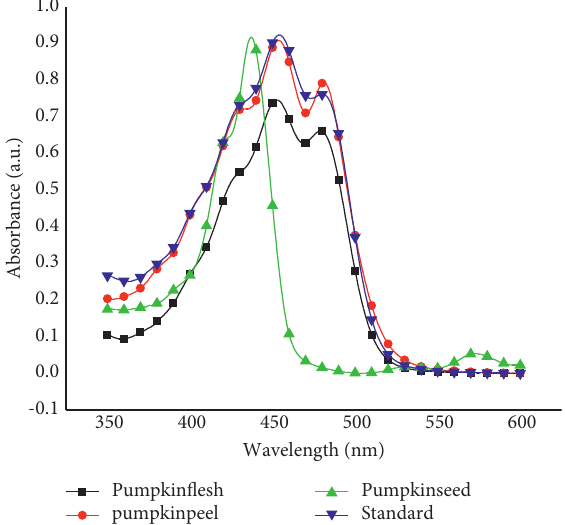
Figure 4: UV-VIS spectra of standard β -carotene and β -carotene extracts from pumpkin flesh, peel, and seed samples.